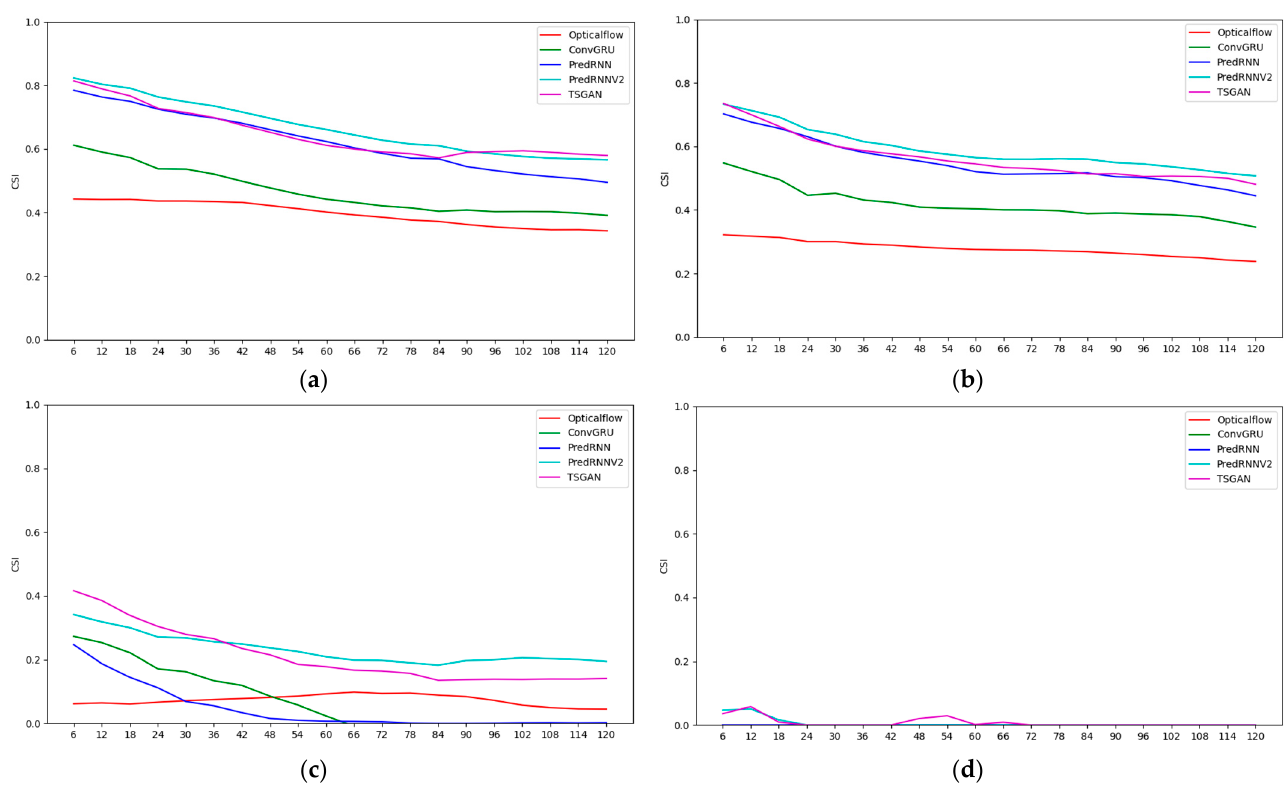
Figure 14. The scores of the critical success index for the forecasts of the typhoon process. ( a ) 20 dBZ;